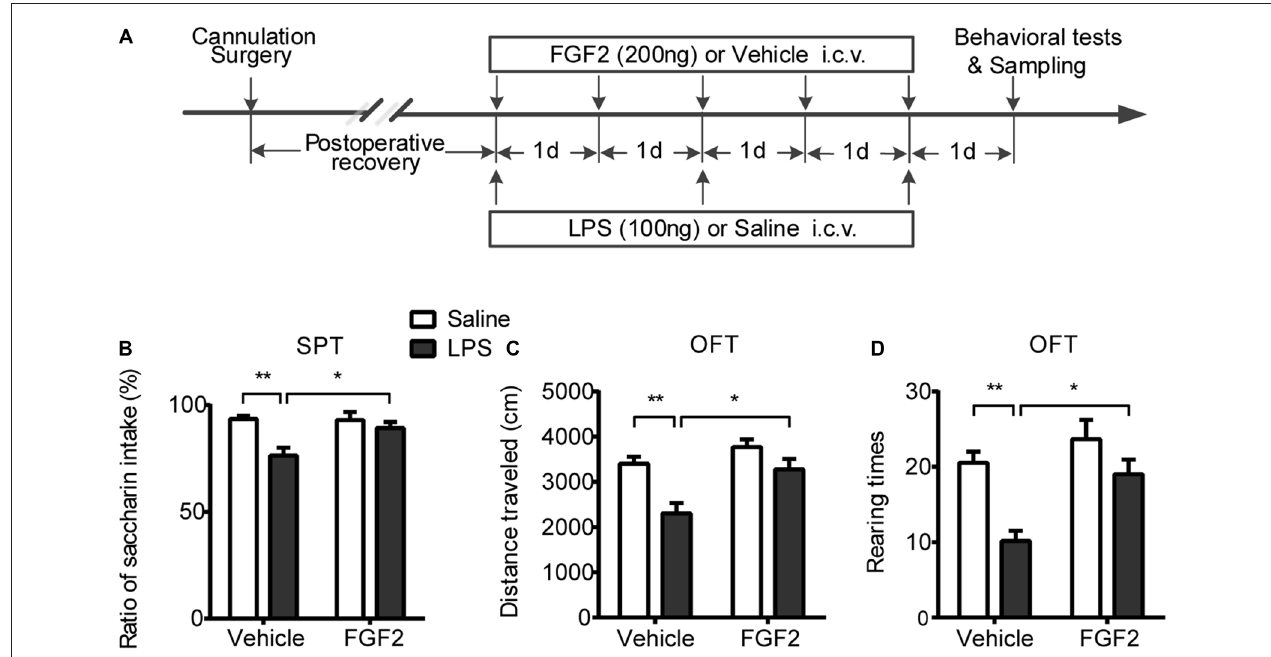
FIGURE 1 | FGF2 reversed the depressive-like behaviors induced by LPS administration. (A) The timeline of Experiment 1. Group LPS + FGF2 received central FGF2 infusions once each day for five consecutive days during the central LPS administration. Three control groups of LPS + Vehicle, Saline + FGF2 and Saline + Vehicle received the corresponding treatments and were served to examine the effects of LPS, FGF2 and Vehicle infusions respectively. The behavioral tests and brain tissues sampling were carried out 24 h after infusions. (B) SPT. The decreased saccharin intake rate was reversed by FGF2 infusions in LPS-treated rats. (C,D) OFT. The decreased distance traveled and rearing times were reversed by FGF2 infusions in LPS-treated rats. Two-way ANOVA with Tukey’s multiple comparisons test, n = 6 per group. Data are presented as the means ± SEM. ∗ p < 0.05, ∗∗ p < 0.01. LPS, lipopolysaccharide; FGF2, fibroblast growth factor 2; i.c.v., intracerebroventricular; SPT, Saccharin preference test; OFT, Open field